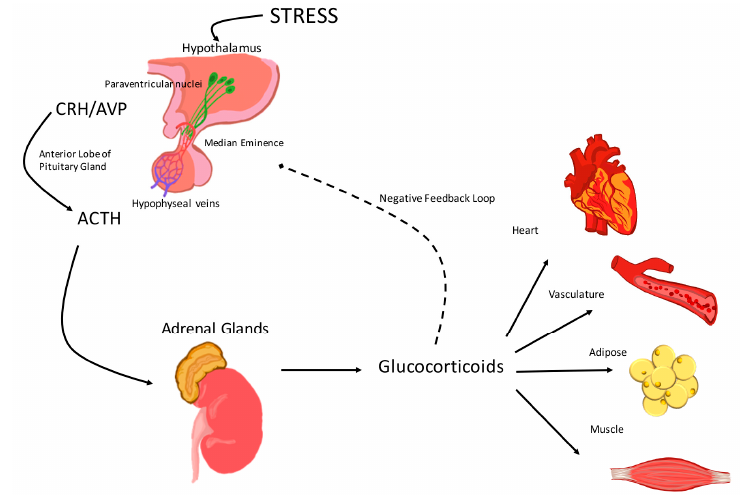
Figure 1. The activation of the hypothalamic-pituitary-adrenal (HPA) axis. Response to a stress stimulus is routed to the hypophysiotropic neurons in the paraventricular nucleus (PVN) of the hypothalamus. These neurosecretory cells release corticotropin-releasing hormone (CRH) and arginine vasopressin (AVP), which travel through the median eminence and hypophyseal portal vessels. Once CRH reaches the anterior pituitary, it binds CRF type 1 receptors of pituitary corticotroph cells. Adrenocorticotropic hormone (ACTH) is released into circulation, binds its receptors in the zona fasiculata of the adrenal cortex, and causes release of glucocorticoids. Glucocorticoids in circulation act on target cardiovascular tissues (including, the heart, the vasculature, adipose tissue and muscle) then feedback to the level of the central nervous system (CNS) to inhibit activation of the HPA axis.